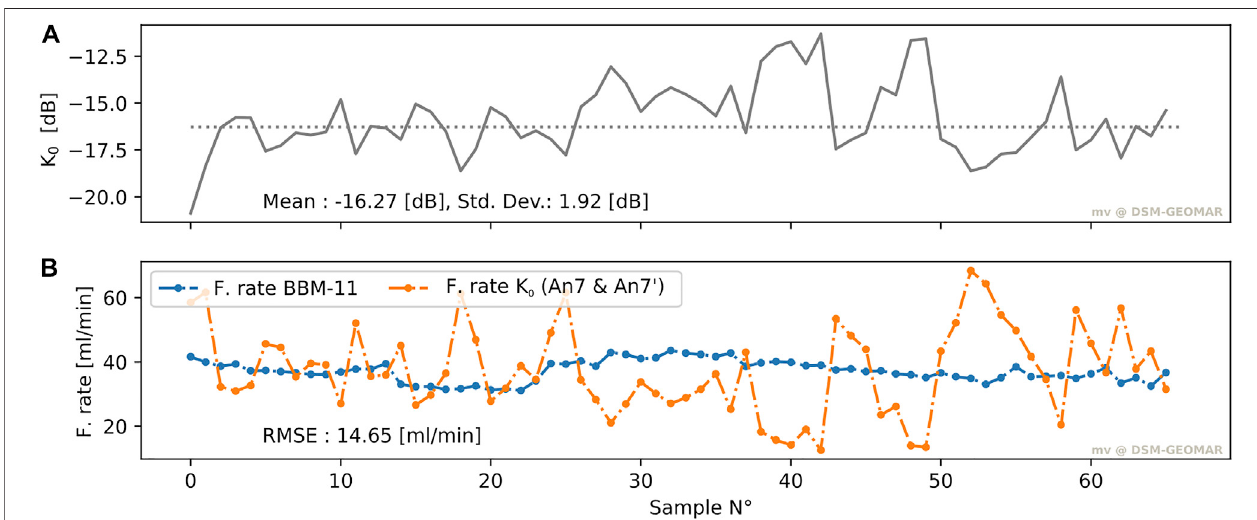
FIGURE 9 | (A) Calculated K 0 value using the contribution of representative amplitudes of the two acoustic anomalies (i.e., An7 & A7 ′ ). The image includes the averagevalue(dottedlines)ofthecalculationof K 0 .value (i.e., (cid:1) K 0 ). (B) Flowratesofcontrolacoustic samplederivedbytheir hydroacousticinformation and itsrespective (cid:1) K fl ow rate optically obtained with the BBox 0 value compared to